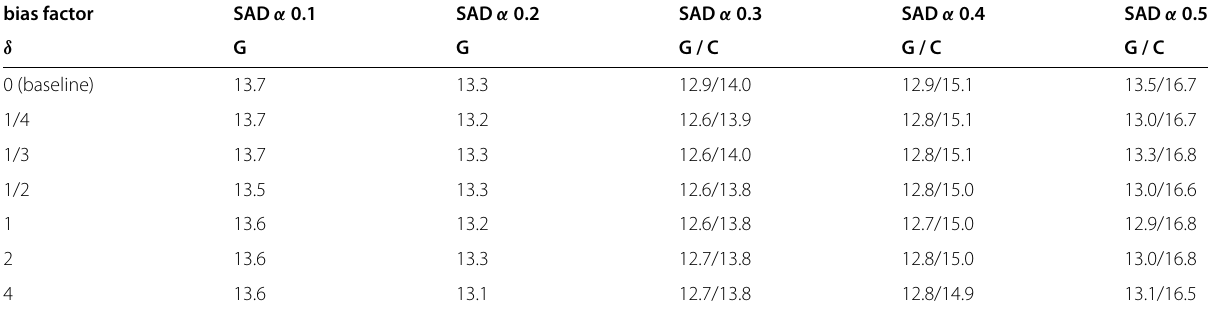
Table 6 A comparison of using different bias factors and SAD dilation-erosion factors ASR Model 1. WERs are in percent and evaluated on the SAD segmented dev dataset. “G” and “C” represent GMM-HMM aligner and CTC aligner, respectively bias factor SAD α